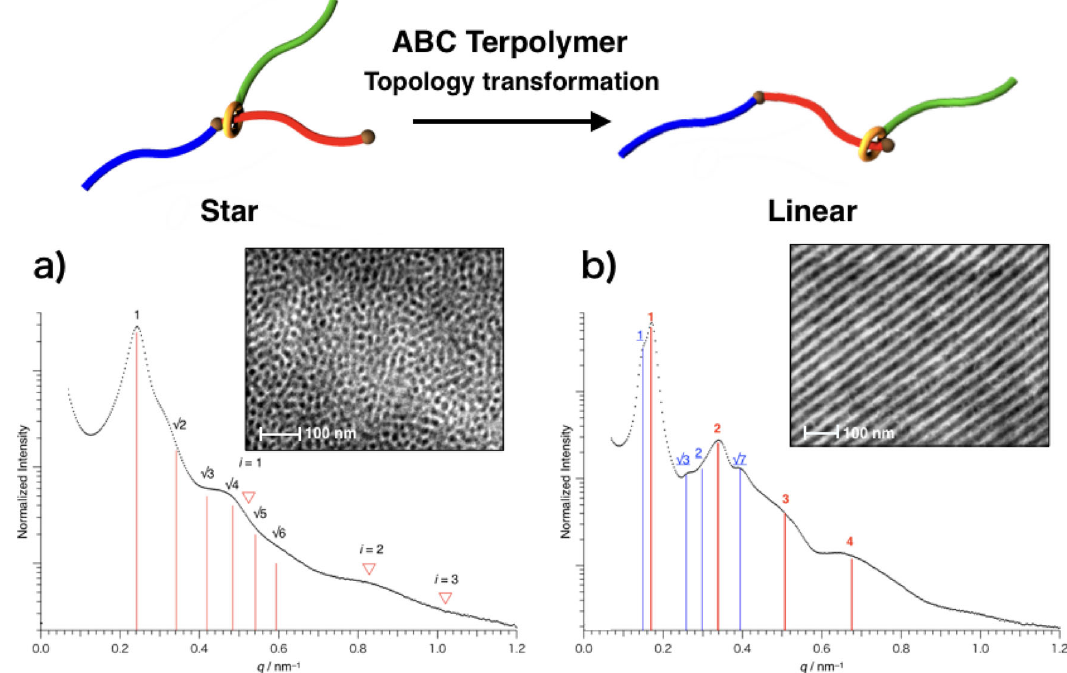
Fig. 4 SAXS pro fi les and bright- fi eld STEM images before (ABC star ) and after (ABC linear ) the topology transformation. a ABC star and ( b ) ABC linear . In the SAXS pro fi le of ABC linear , the peak positions of lamellar and cylinder-like structures are indicated by red and blue,